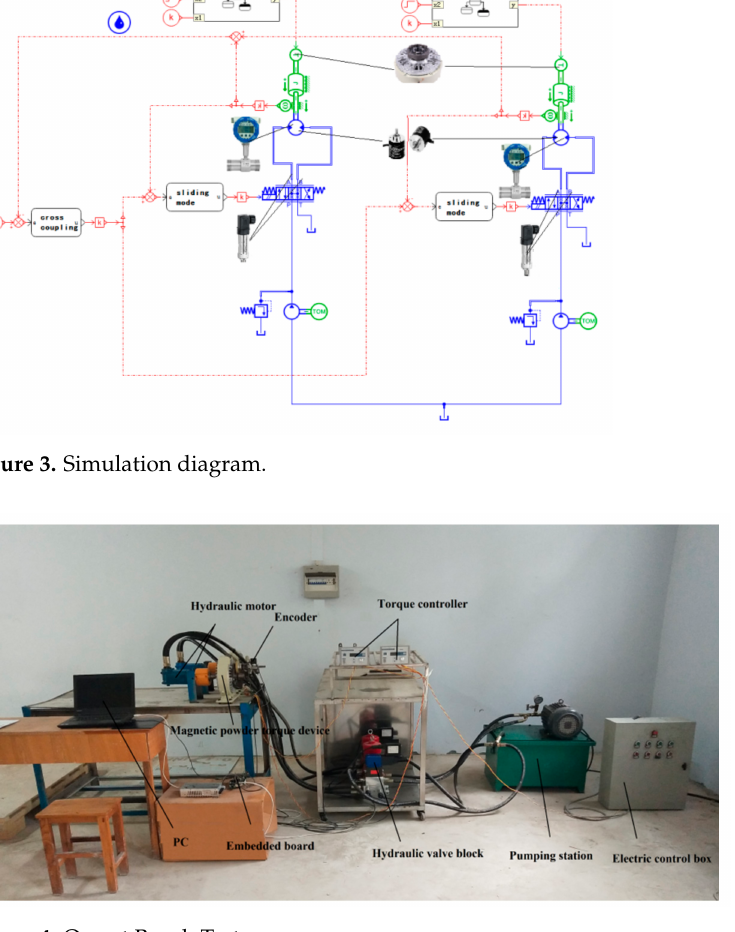
Figure 4. On-set Bench